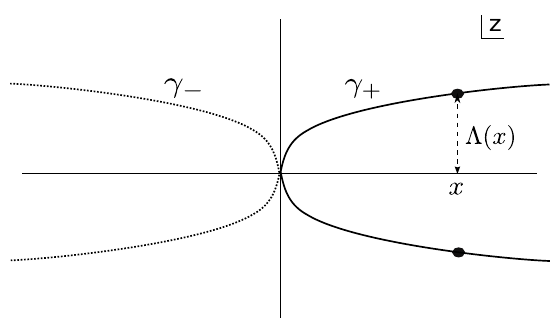
Figure 17 . (cid:13) + (solid line) and (cid:13) (cid:0) (dashed line) integration contour in the z